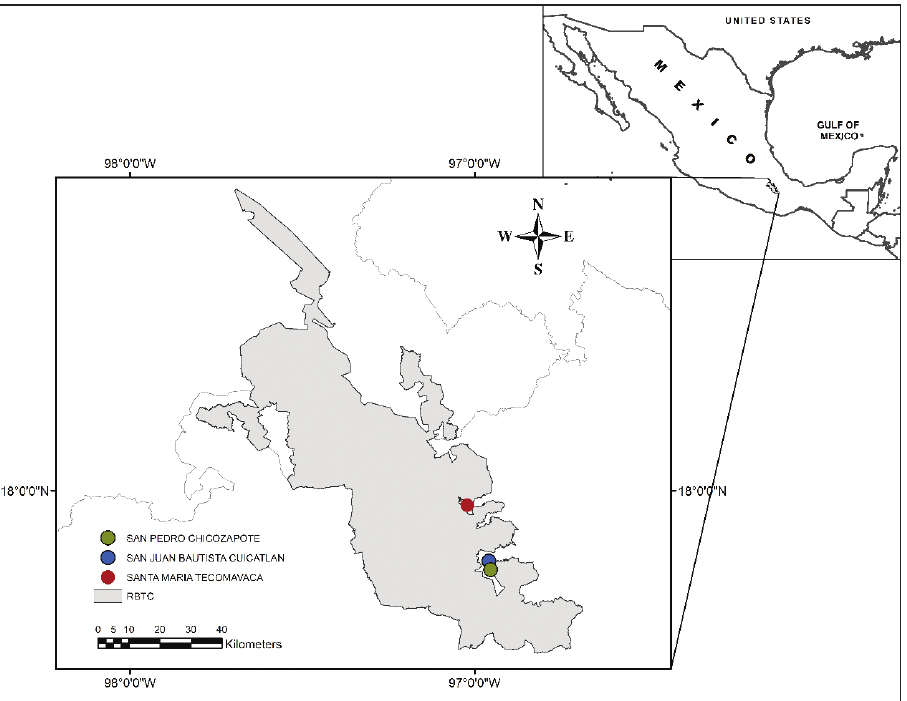
Figure 1. Localities studied in the RBTC. Map was elaborated with